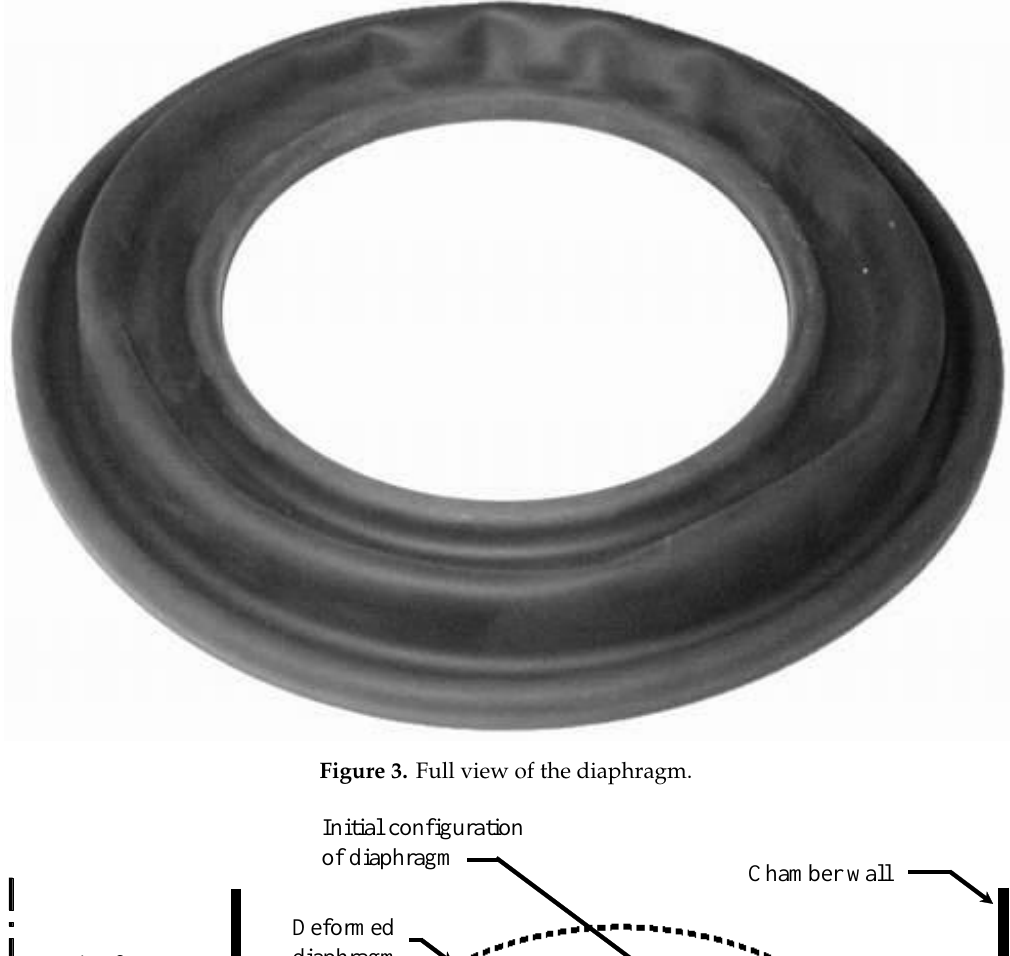
Figure 3. Full view of the diaphragm.